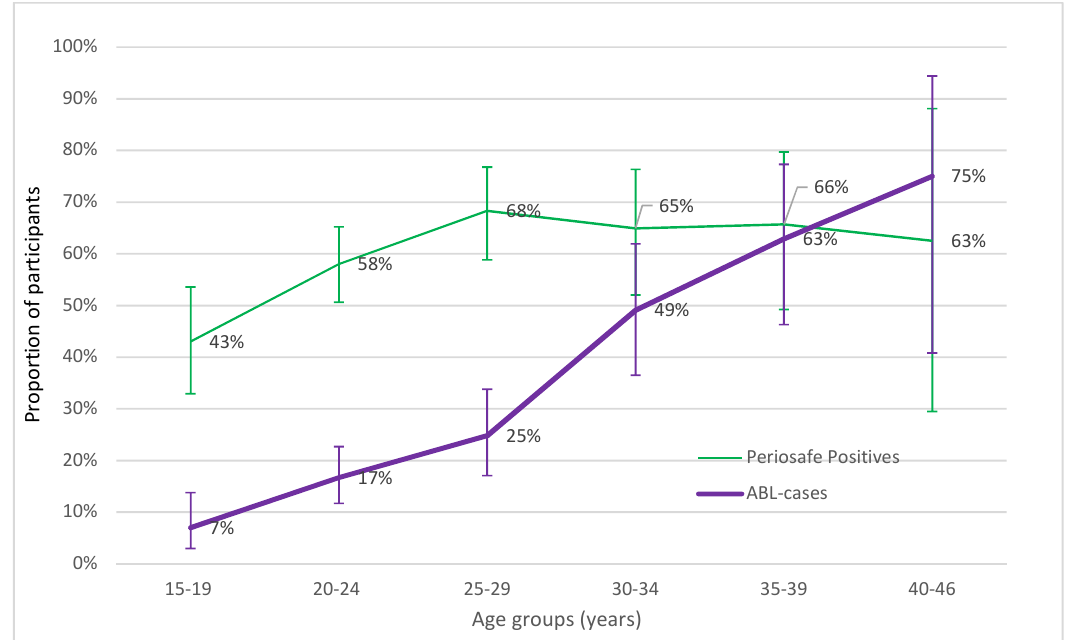
Figure 1. Proportion (%) of patients with aMMP-8 test positive result or ABL detected in radiographs. The proportion of aMMP-8 test positives is higher in young participants when compared to ABL.